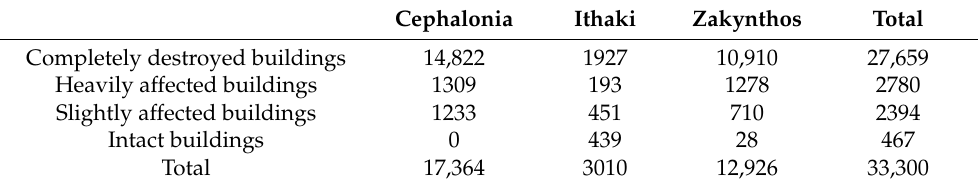
Table 2. Damage grades in the southern Ionian Islands induced by the 12 August 1953 earthquake and its foreshocks on 9 and 11 August [data based on Grandazzi [16]]. Cephalonia Ithaki Zakynthos Total Completely destroyed buildings 14,822 1927 10,910 27,659 Heavily affected buildings 1309 193 1278 2780 Slightly affected buildings 1233 451 710 2394 Intact buildings 0 439 28 467 Total 17,364 3010 12,926